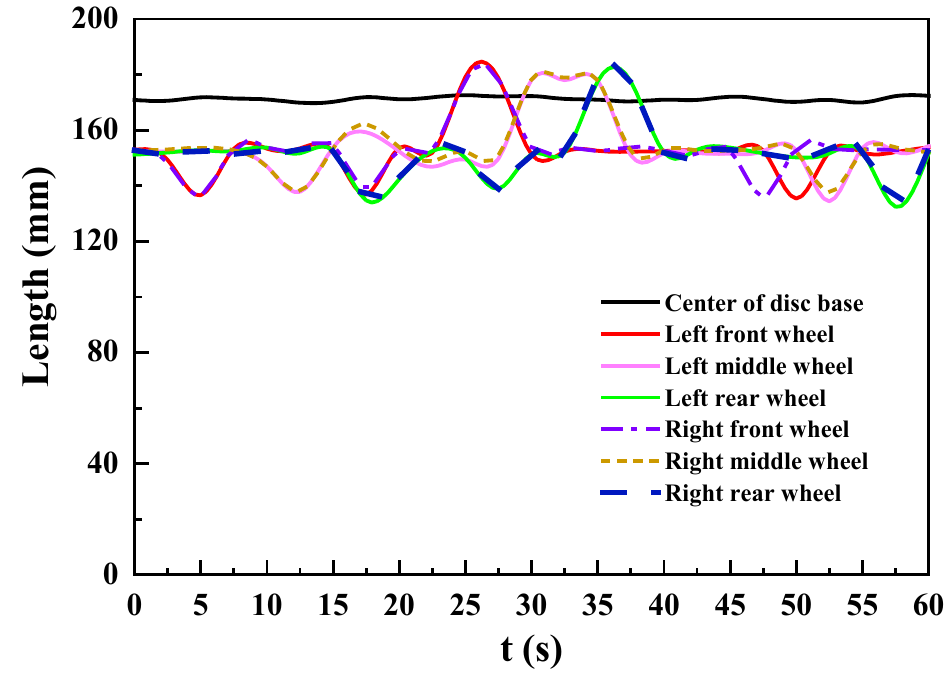
Figure 24. Motion track of upper plate and wheel center on the pothole road.